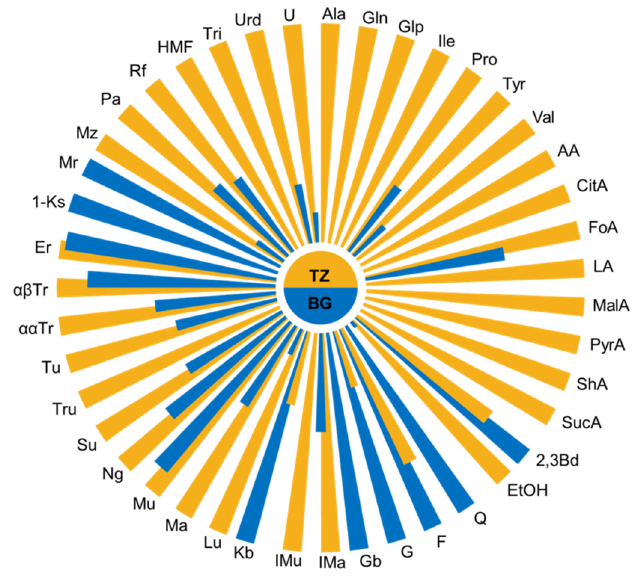
Figure 3. Nightingale’s diagrams for the average content of studied components in M. ferruginea (TZ) and Bulgarian A. mellifera honeys (BG). Acronyms according to Figure 1.